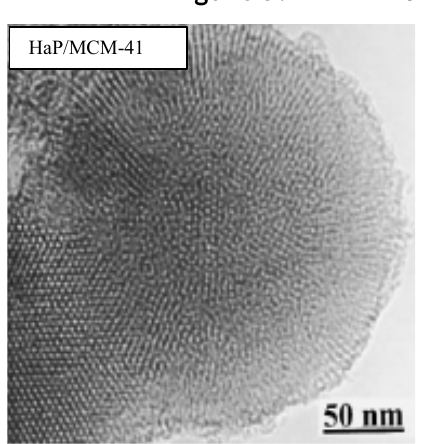
Figure 5. HRTEM of HaP/MCM-41 and